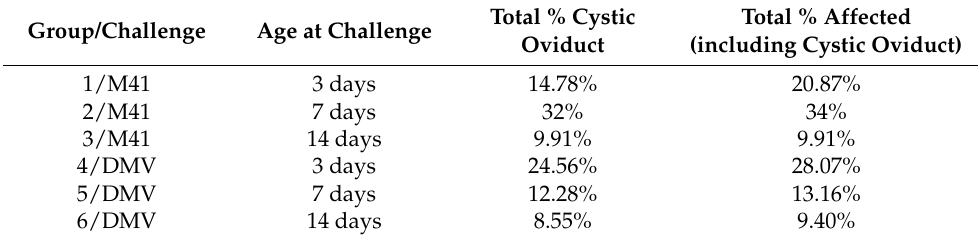
Table 3. Percentage of Cystic and Affected Oviduct per